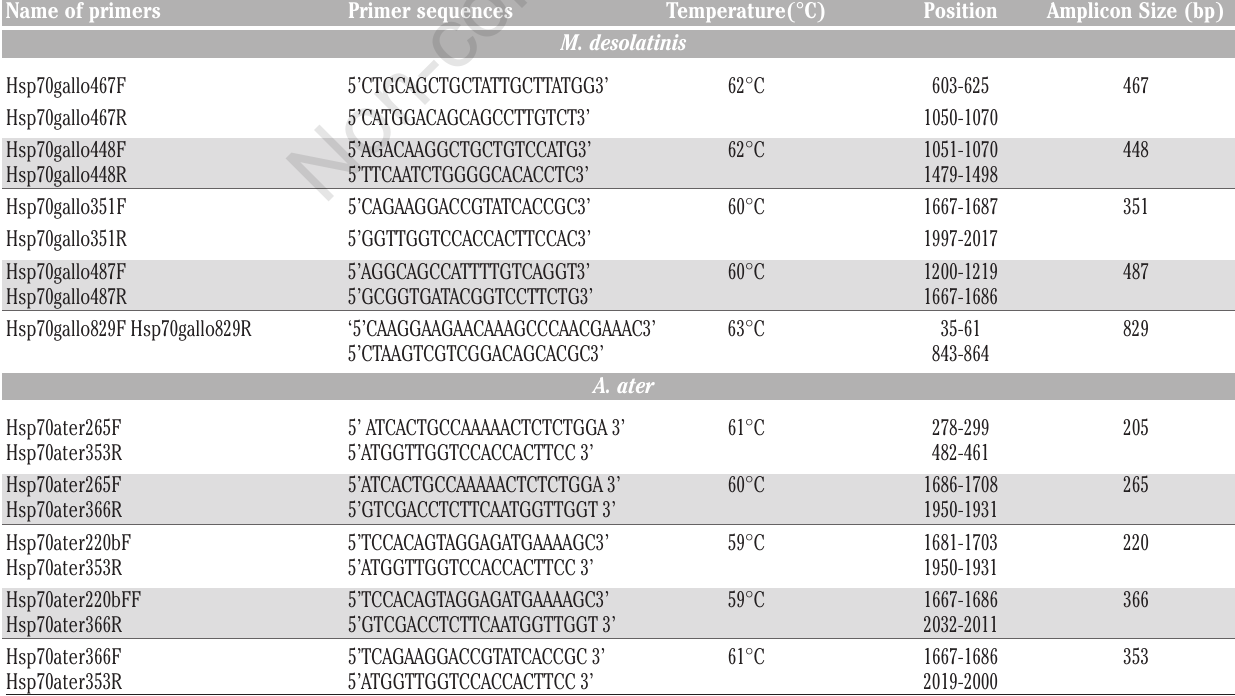
Table 1. List of oligoprimers used for amplification of hsp70 of A. ater and M. desolationis. Name of